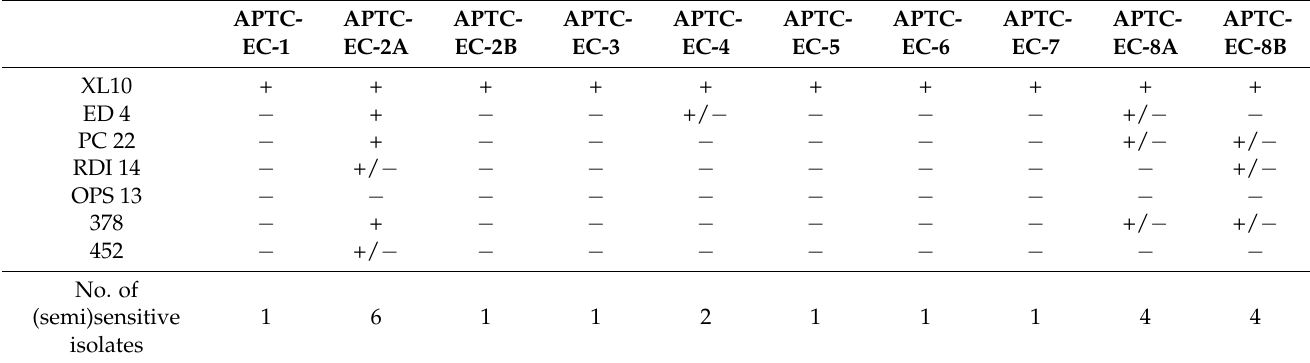
Table 4. Phage host range tests. Each phage (APTC-EC-1- APTC-EC-8B) host range was determined against 7 E. coli strains (XL10, ED 4, PC 22, RDI 14, OPS 13, 378, 452). + = clear plaque; +/ − =